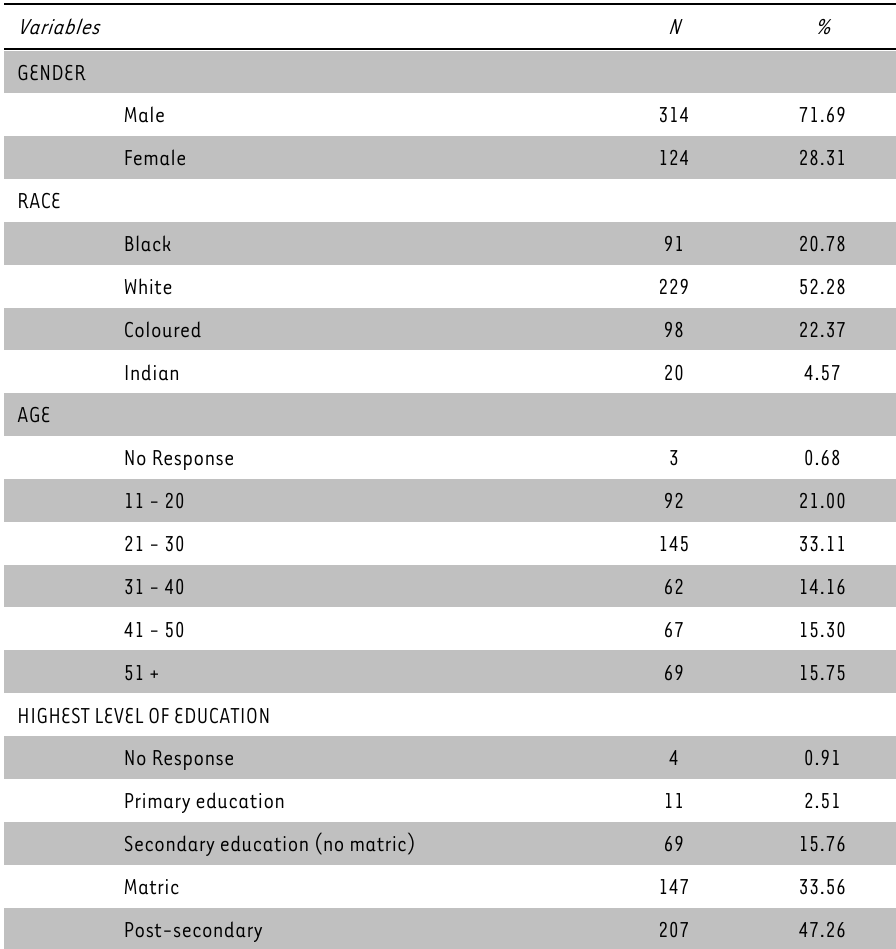
TABLE 1: Summary descriptive statistics